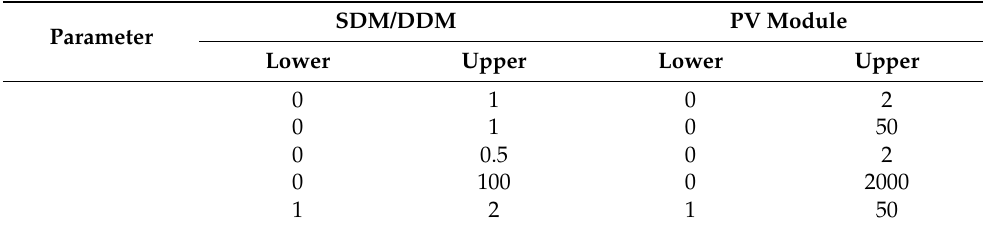
Table 3. Parameters ranges of PV models.